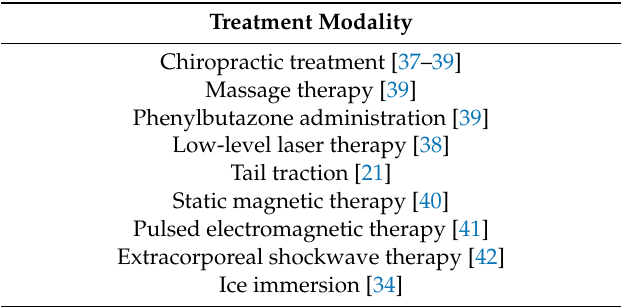
Table 19. Use of pressure algometry to assess various treatment